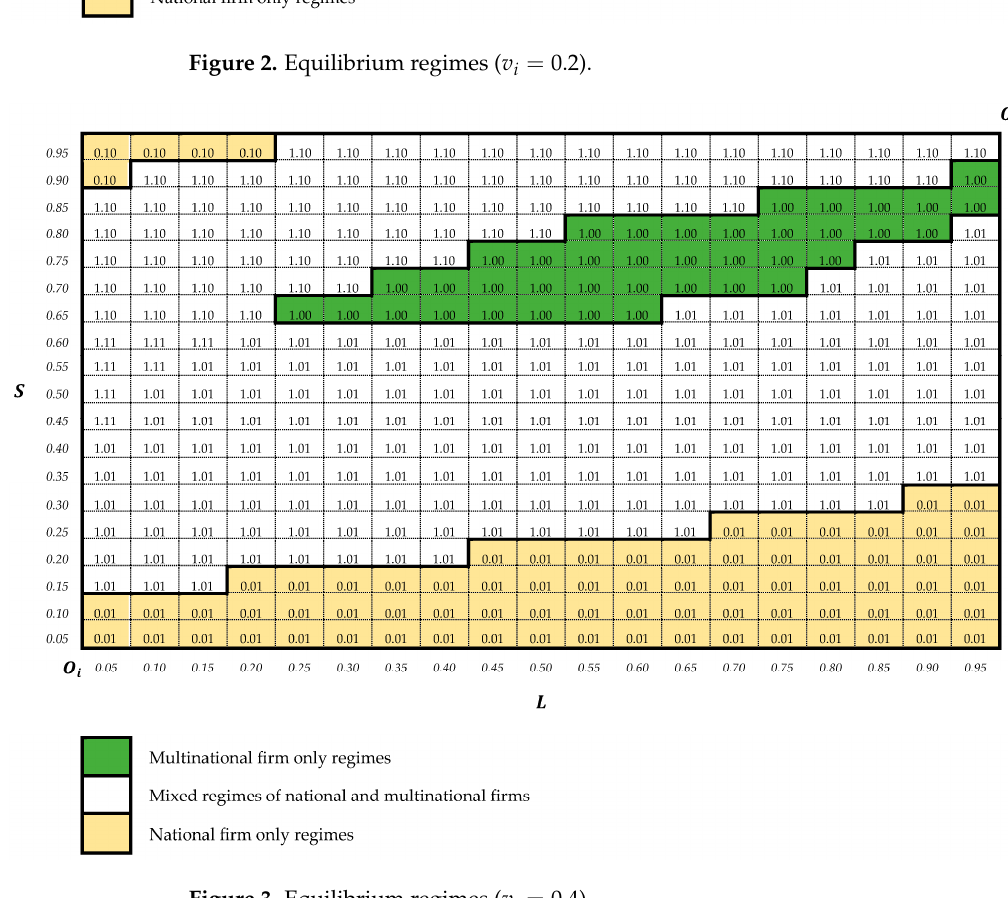
Figure 3. Equilibrium regimes ( 𝑣 (cid:3036) = 0.4 ).